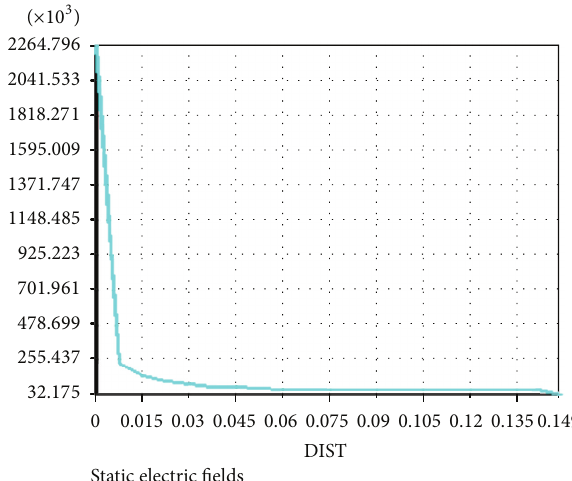
Figure 5: Influence of the collecting distance on the electric field intensity.